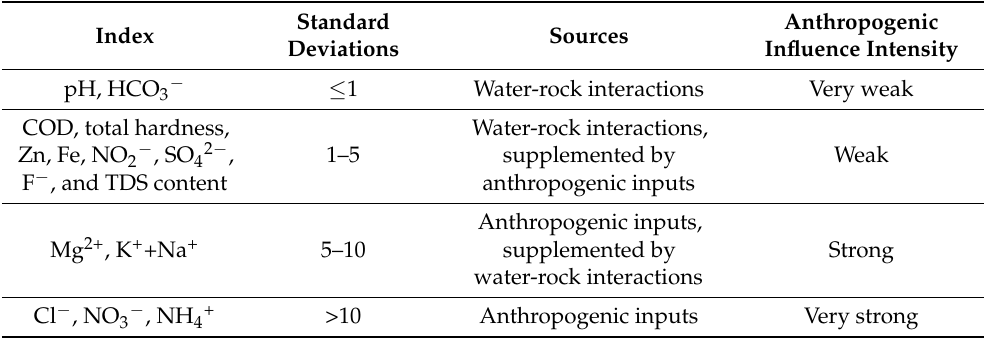
Table 5. Standard deviations of the contrast coefficients of indices and their indicative